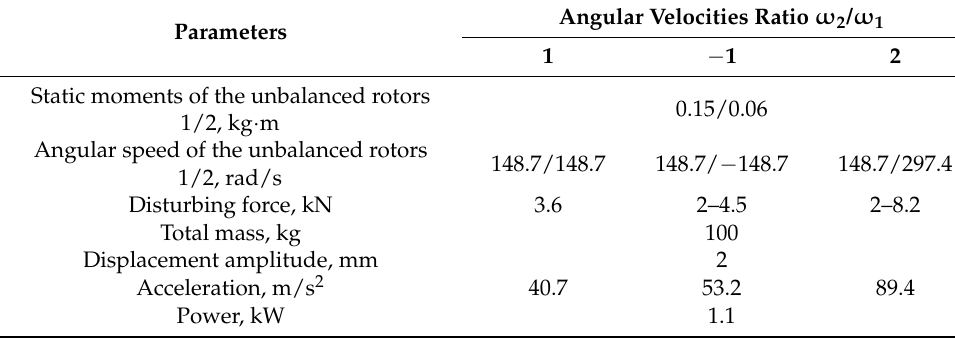
Table 3. Technical characteristics of the vibratory system.